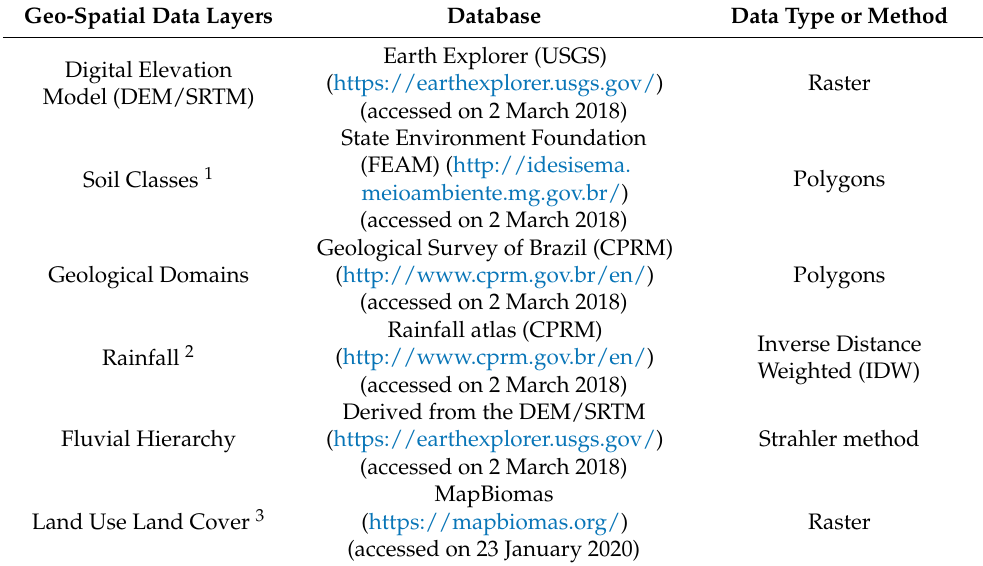
Table 1. Databases, acquisition sources, and methods applied to the data set.